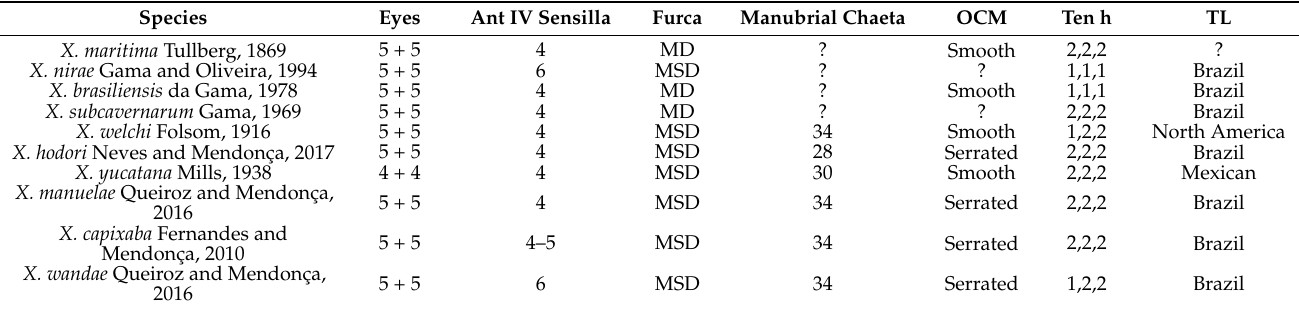
ordinary chaetae morphology; TL—type locality; MD—mucrodens, MSD—mucro separate from dens; “?”—missing date.